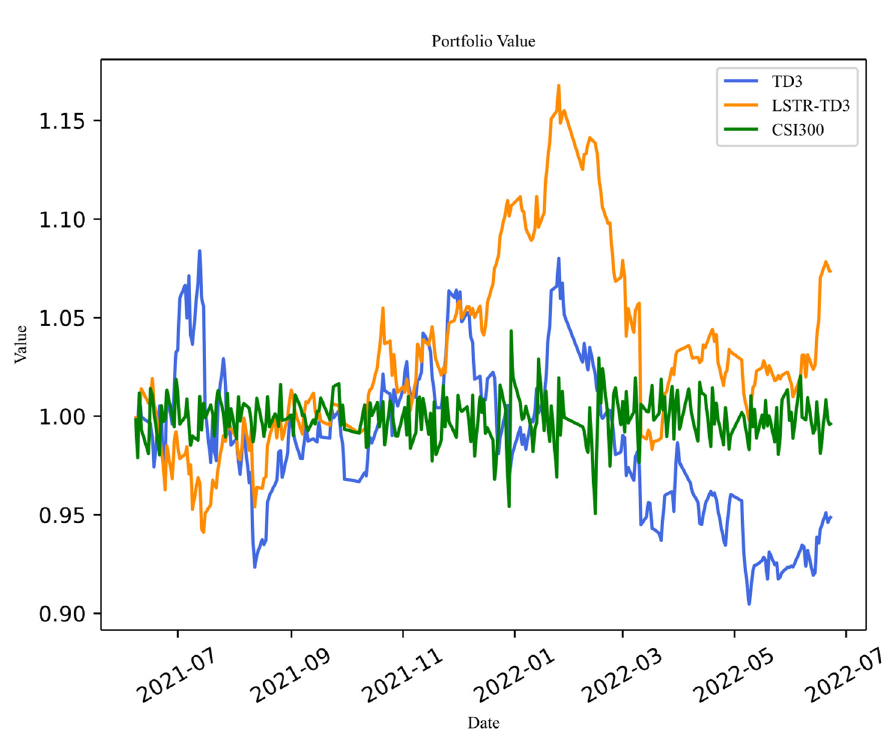
Figure 12. Portfolio value of Portfolio 3.